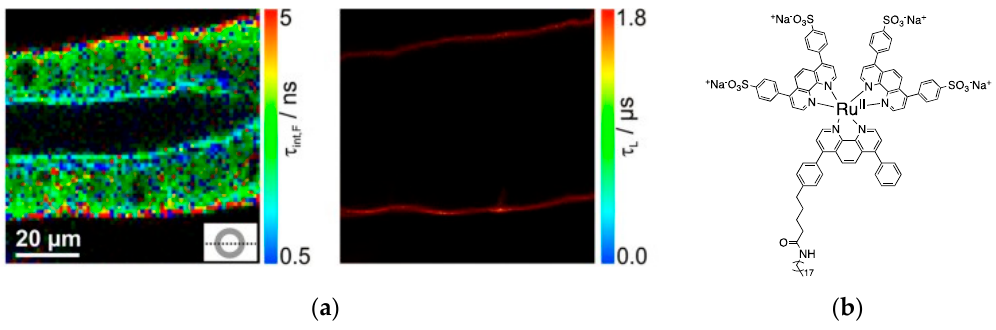
Figure 5. ( a ) Emission lifetime map of cockroach salivary ducts stained with a Ru II complex using FLIM (left) or PLIM (right). ( b ) Structure of the Ru II complex. Reproduced from [117].